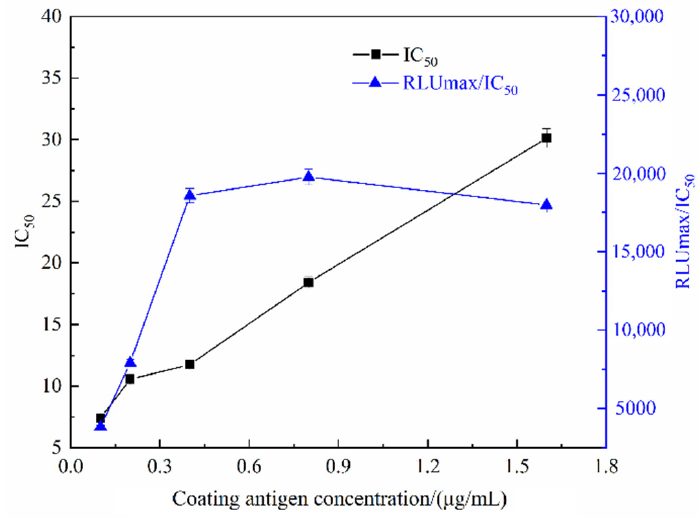
Figure 1. The IC 50 and RLUmax/IC 50 of ic-CLIEA under different coating antigen concentrations for ACE detection.